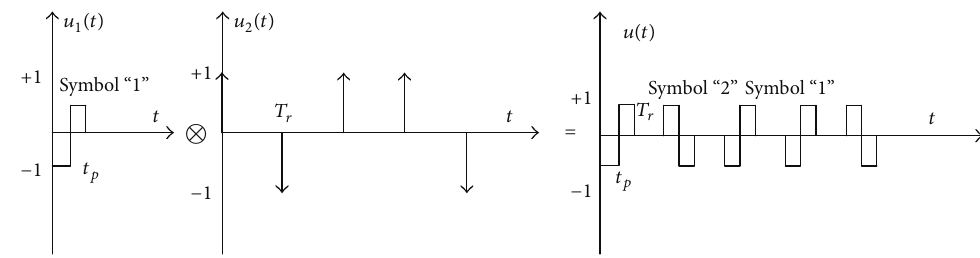
Figure 6: Interpulse biphase code